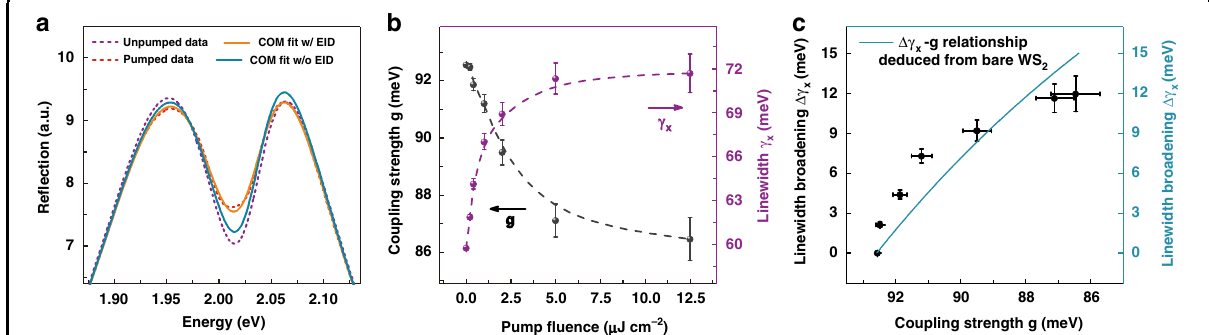
Fig. 3 Saturation and dephasing nonlinearities in plexcitons. a COM fi tting results of the plexciton re fl ection spectrum at an incident fl uence of 2.0 µJ cm − 2 with (orange solid line) and without (blue solid line) the EID effect. The red dashed line represents the pumped plexciton re fl ection spectrum at t = 100 fs, and the purple dashed line is the plexciton re fl ection spectrum unaffected by the pump excitation. b Plasmon – exciton Þ parameters (dots) at various incident fl uences obtained from COM fi tting. The dashed coupling strength ( g ) and exciton resonance linewidth ð γ x – g parameters (black dots) directly extracted from b with the Δ γ – g relationship (blue lines are guides for data classi fi cation. c Comparison of the Δ γ x x denotes the broadening of the exciton resonance solid line) indirectly derived from the bare WS 2 excitons, in which Δ γ x